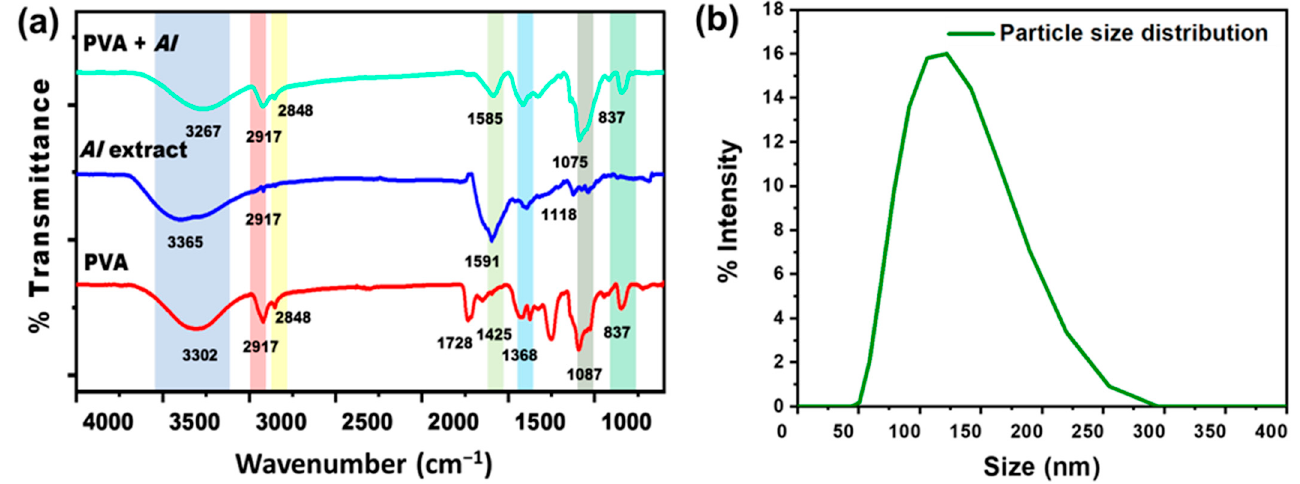
Figure 4. ( a ) FTIR spectra of PVA, AI extract, and AI incorporated with PVA nanofibers sheet ( b ) AI particle size distribution through DLS.